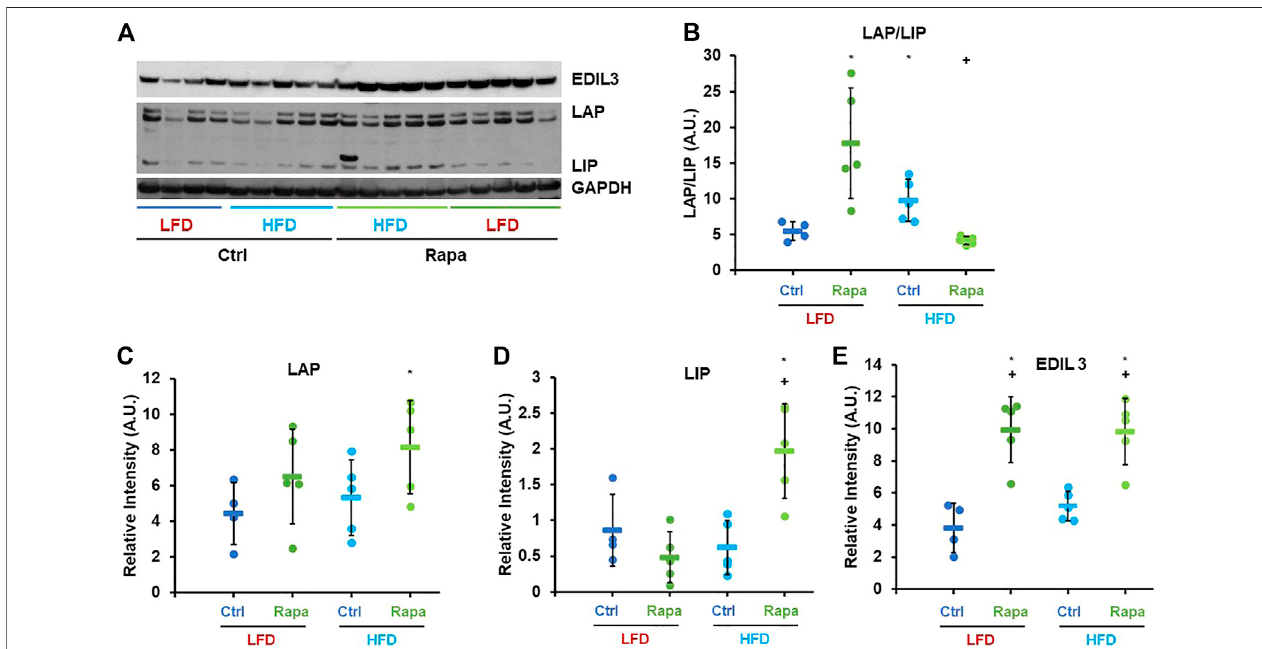
FIGURE 3 | Rapamycin increases expression of C/EBP- β LAP and EDIL3. (A) Representative western blot image against EDIL3, C/EBP- β (LAP and LIP isoforms) and GAPDH. (B – E) Densitometric analysis of the western blot in panel (A) Circles: individual animals, bars: average + - standard deviation. *: p < 0.05 vs LFD control,